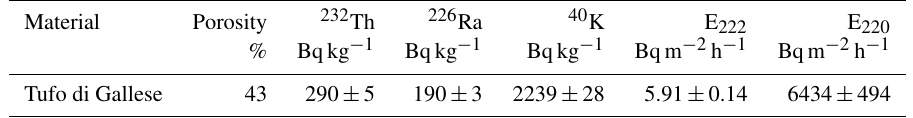
Table 1. Porosity, 232 Th, 226 Ra and 40 K specific activities and 222 Rn and 220 Rn exhalation rates of “Tufo di Gallese” ignimbrite. Material Porosity 232 Th 226 Ra 40